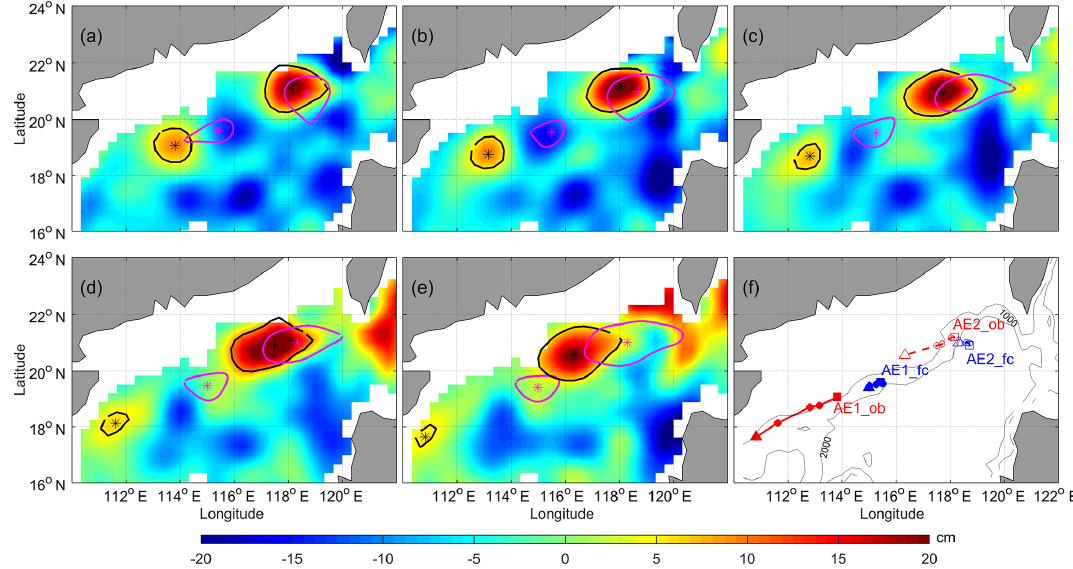
Figure 12. Same as Fig. 11, but for Exp5; the experiment period is the 8 February to the 10 March 2004.